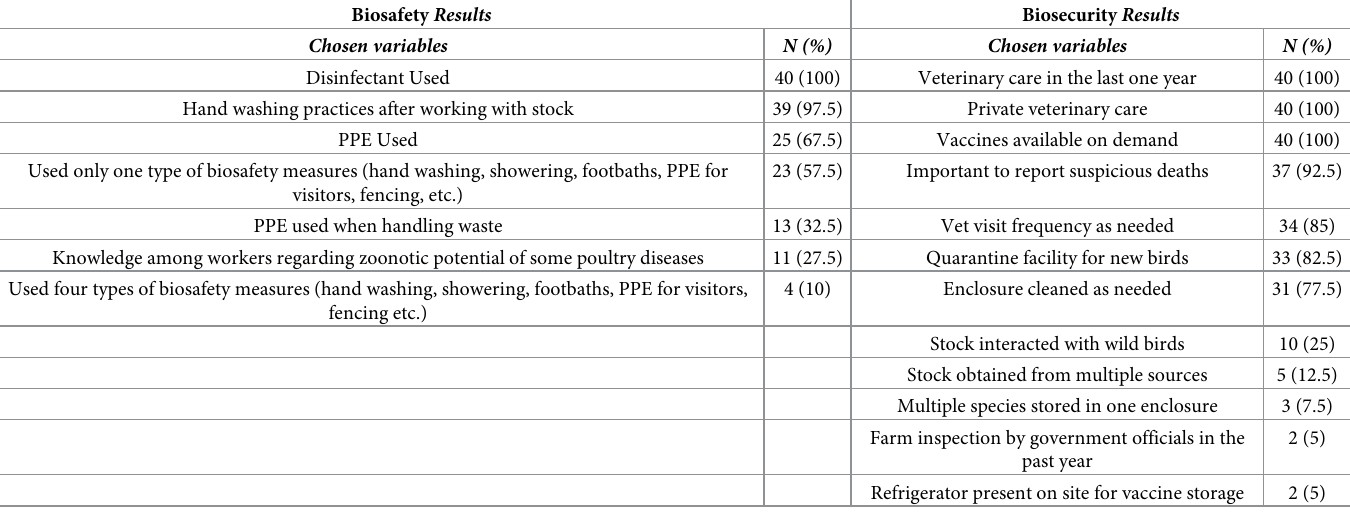
Table 7. Biosafety (left) and Biosecurity (right) results of commercial farms (n = 40) sampled by BIOVAC. Biosafety